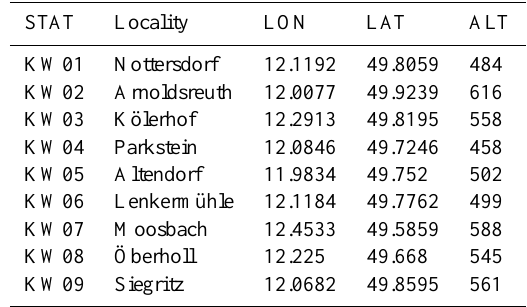
Table 1. Station